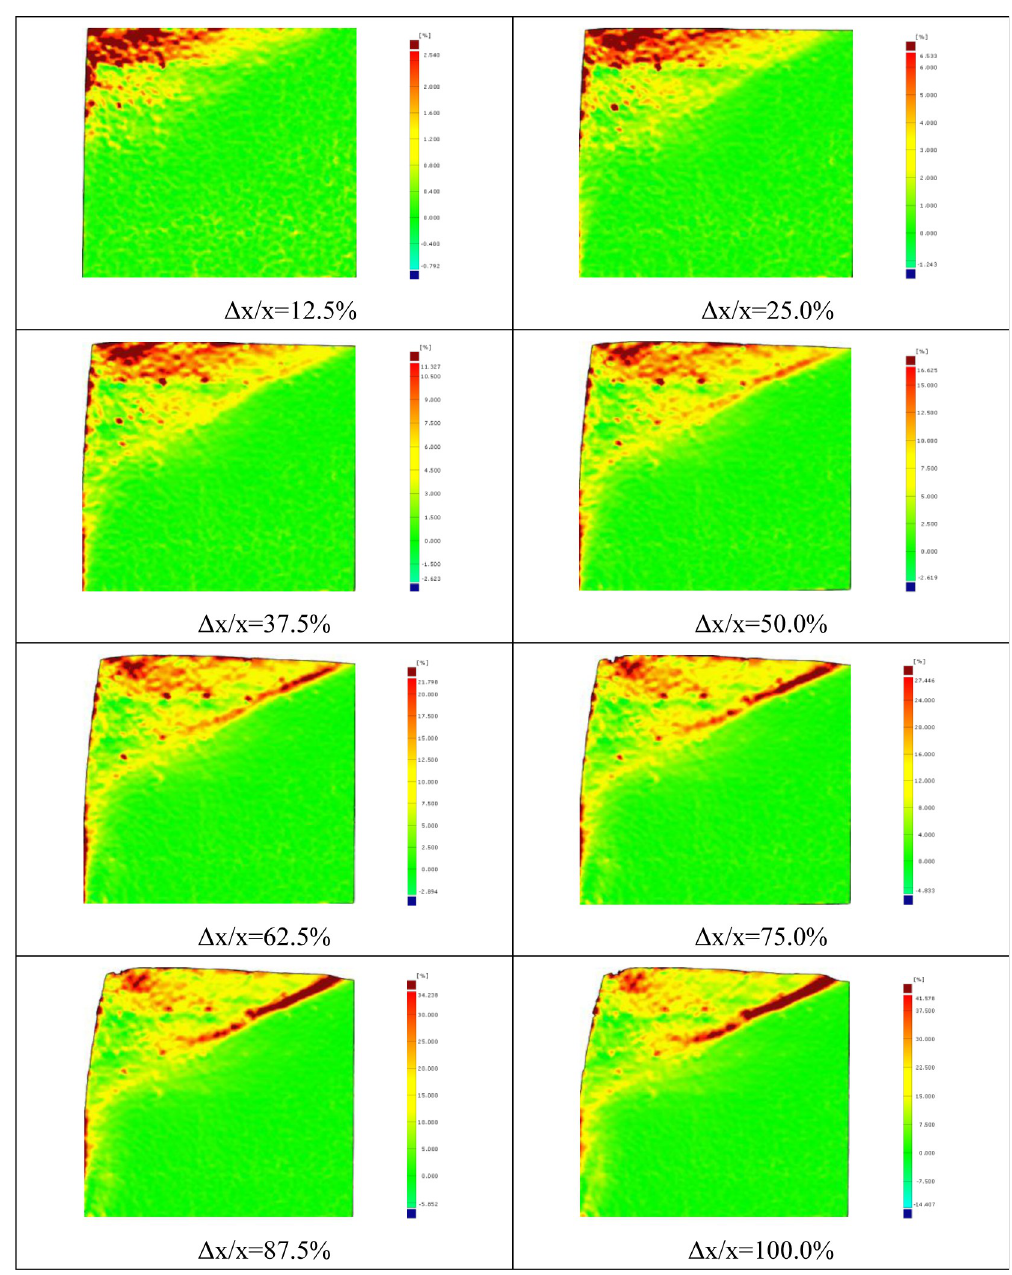
Fig 5. Shear strain nephogram of soil at different stages